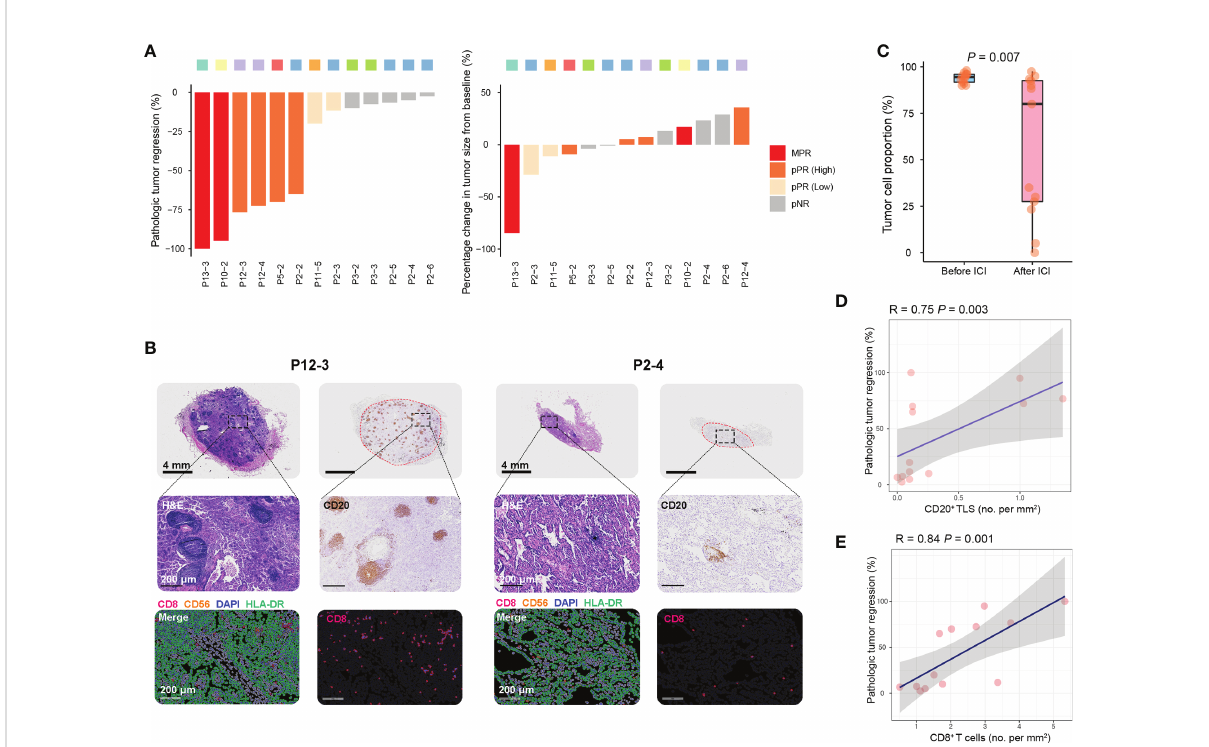
FIGURE 3 Immune responses to Sintilimab in sMPLC. (A) Waterfall plots of pathologic tumor regression and radiographic change in resected GGOs after the use of Sintilimab. Primary endpoint: MPR ( ≤ 10% viable tumor cells), pPR (>10% and<90% viable tumor cells), and pNR (>90% viable tumor cells). GGOs with pPR were further grouped by median value of viable tumor cell percent. (B) Quanti fi cation of residual viable tumor, CD20 + B- cells, and CD8 + T-cells of GGOs with favorable or poor pathologic response. (C) Comparison of qualifying residual viable tumor before and after the use of Sintilimab. (D, E) The association between CD20 + B-cells and CD8 + T-cells densities and pathologic responses among GGOs underwent immunotherapy. Quanti fi cation methods of tumor in fi ltrated B-cells and T-cells were shown in Methods. MPR, major pathologic response; pPR, pathologic partial response; pNR, pathologic nonresponse; ICI, immune checkpoint